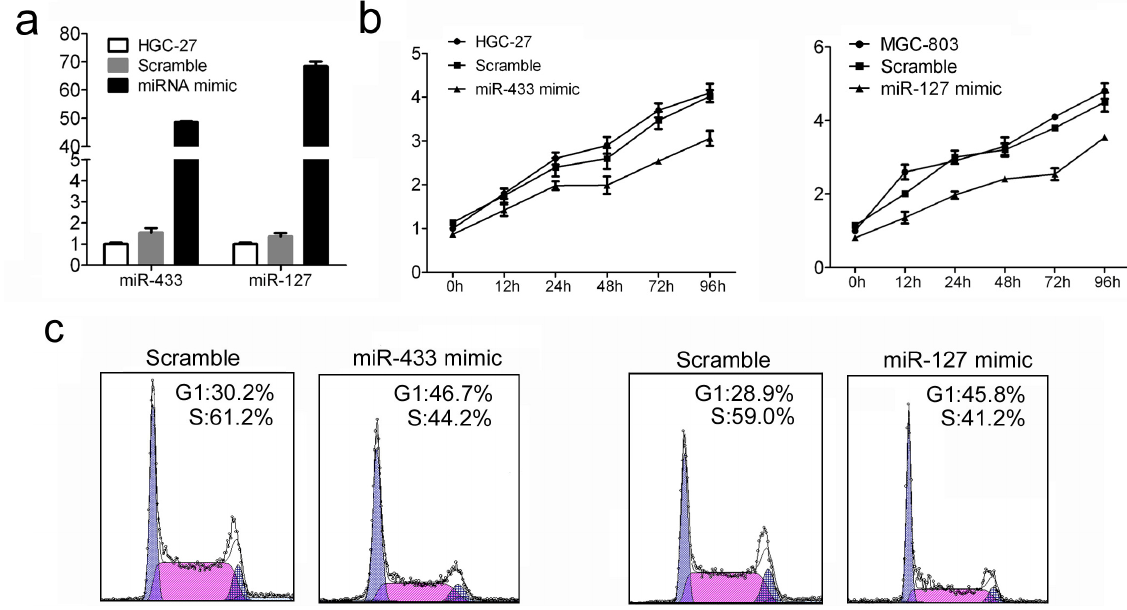
Figure 2. The influence of miR-433 and miR-127 on GC cell proliferation and cell cycle progression. ( a ) MiR-433 and miR-127 level were detected in HGC-27 cells after treatment with miRNA mimic (30 nM) or Scramble (30 nM) by quantitative RT-PCR; ( b ) Cell proliferation assay of HGC-27 cells after treatment with miRNA mimic or Scramble by using CCK-8; ( c ) Cell cycle analysis of HGC-27 cells after treatment with miRNA mimic or Scramble by Propidium Iodide (PI)